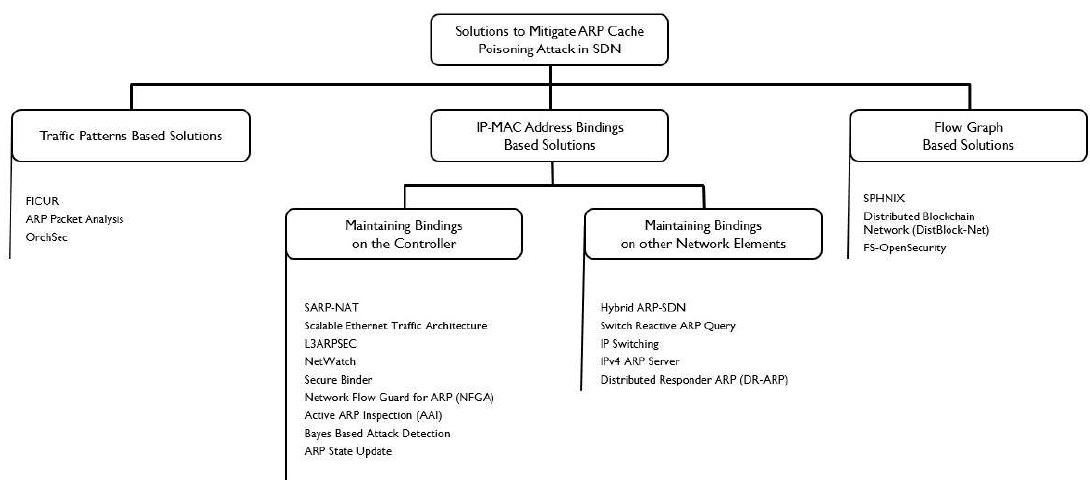
Figure 4. Classification of Solutions for ARP Cache Poisoning Attack in